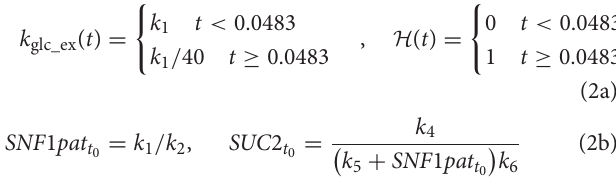
Frontiers in Physiology |